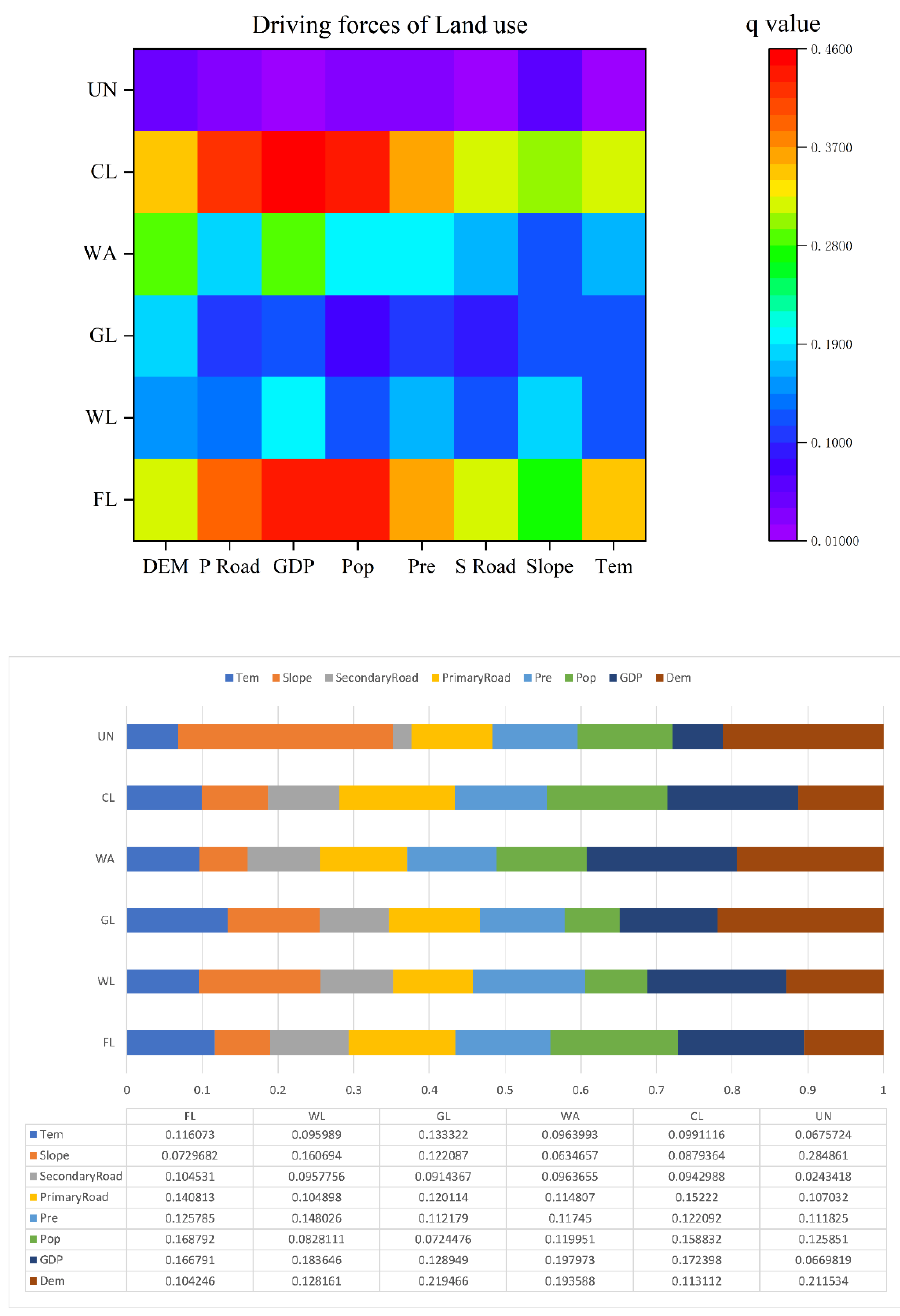
Figure 9. Driving forces of land use change from 1980 –